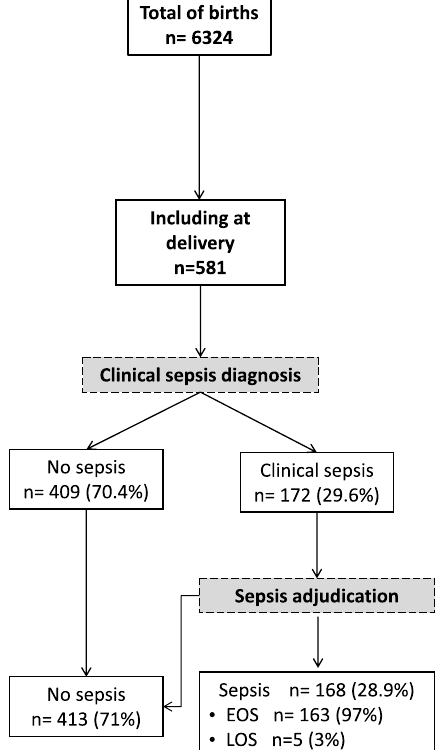
Figure 1. Flow diagram of study population. Recruitment and flow of newborn with risk of neonatal sepsis. At delivery, clinical sepsis diagnosis was established by the local pediatricians based on the child clinical examination and initial workup including haemogram, C-reactive protein (CRP) and microbiological cultures (blood, cerebral fluids and urine). All newborns with a clinical sepsis were subsequently adjudicated by two independent pediatricians and sorted into ‘LOS’ and ‘EOS’ (Figure drawn using Microsoft PowerPoint 2016, Redmond,